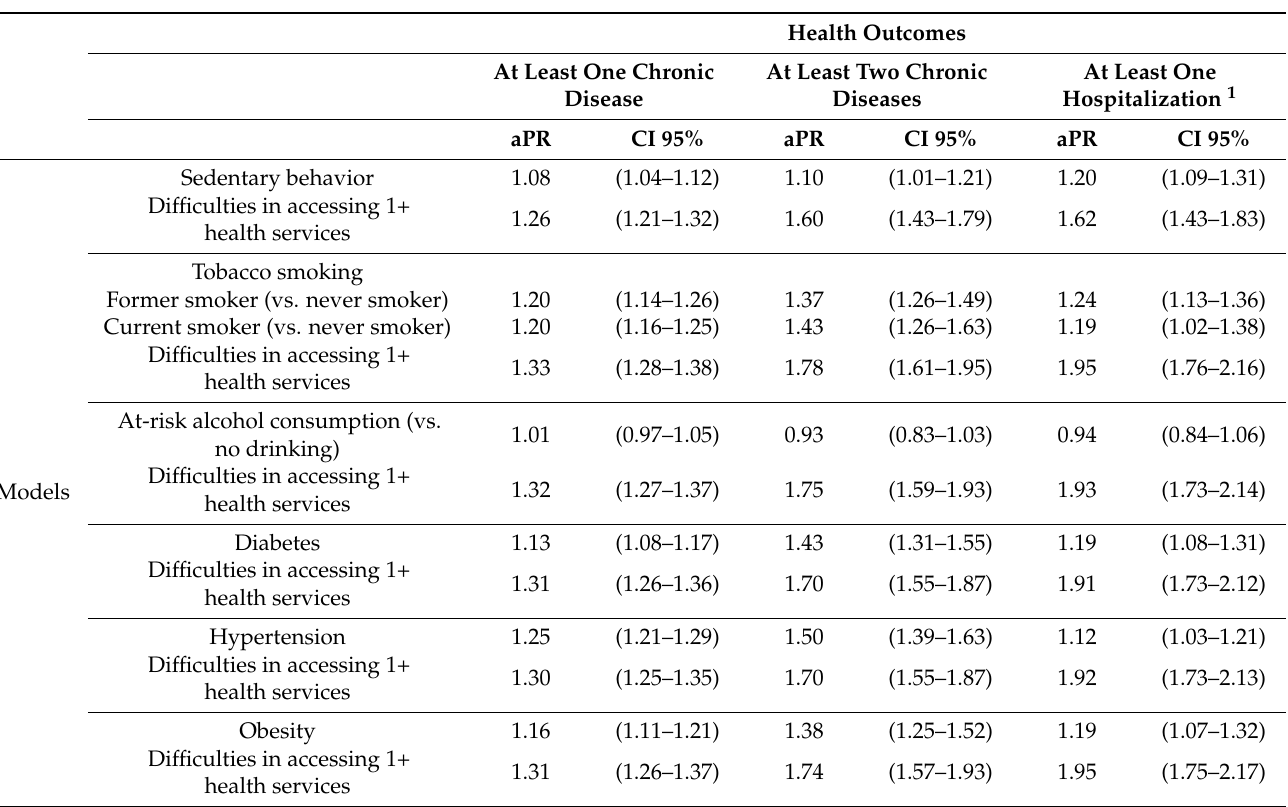
Table 2. Adjusted prevalence ratios (aPR by Poisson regression model) and relative confidence intervals at 95% (95% CI), for health risk factors and access to health services associated with health outcomes (presence of chronic diseases, hospitalization). Passi d’Argento, 2016–2019 ( n = 45,514 out of 56,352). Health Outcomes At Least One Chronic At Least Two Chronic At Least One Disease Diseases Hospitalization 1 aPR CI 95% aPR CI 95% aPR CI